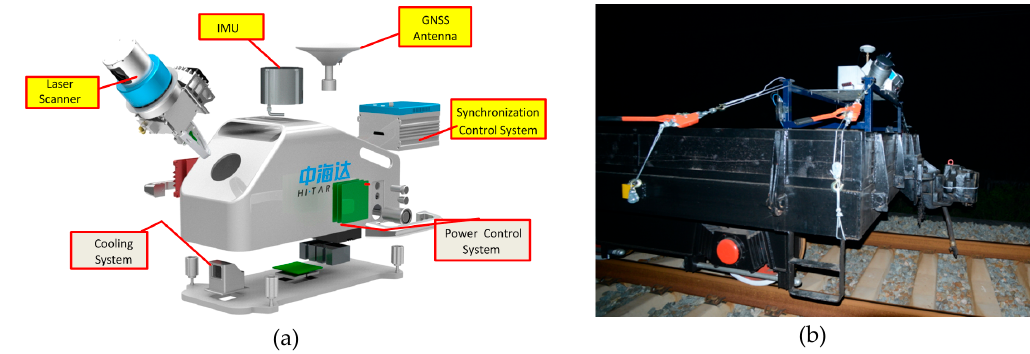
Figure 14. Mobile Laser Scanner (MLS) for railway tunnel point cloud collection. ( a ) Components of MLS; ( b ) MLS on platform trailer for field data collection.